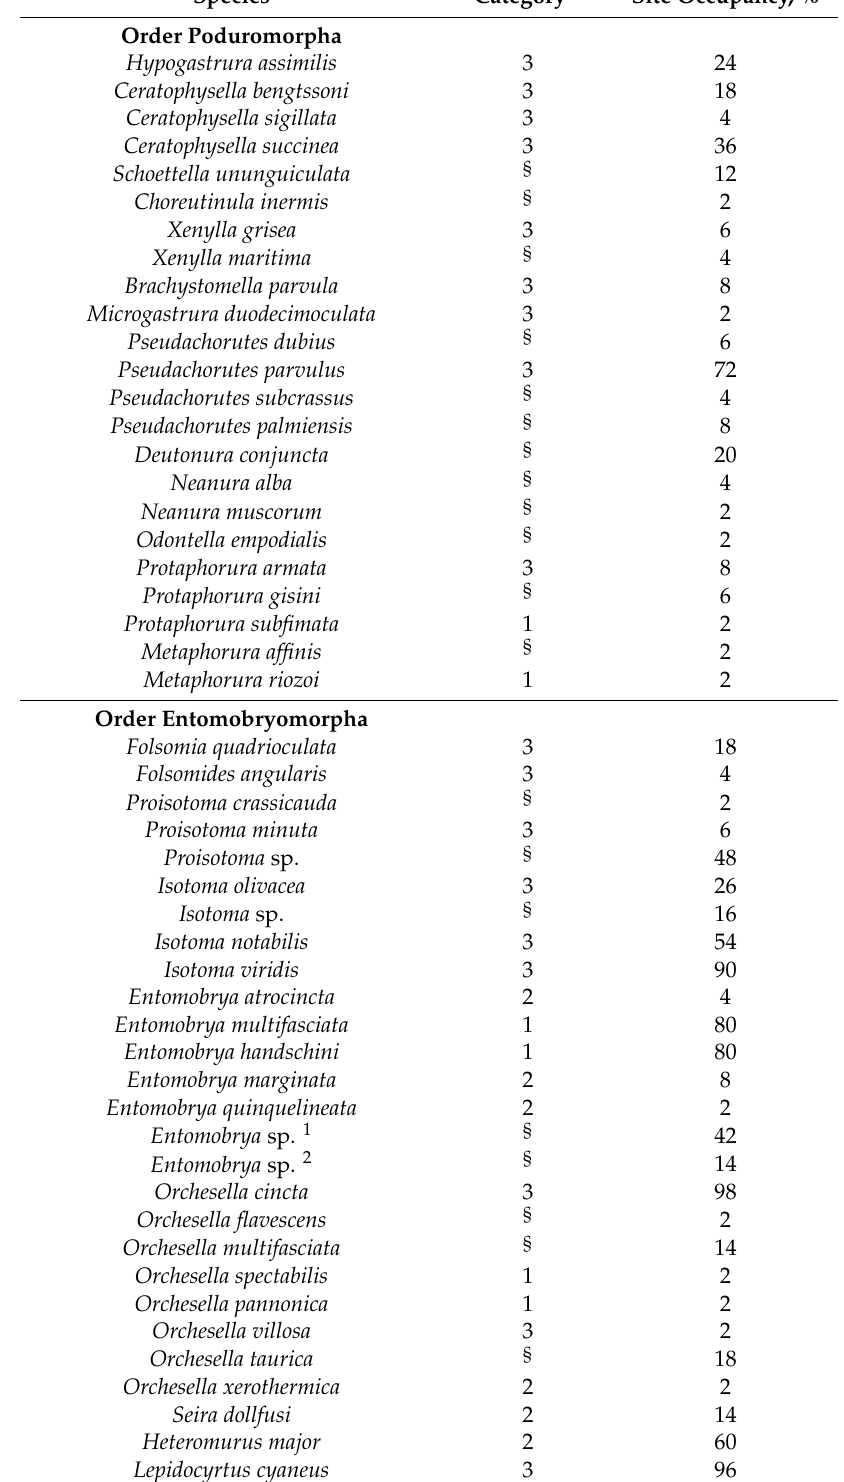
Table 1. Species list of the Collembola found on 50 dry grassland sites in Eastern